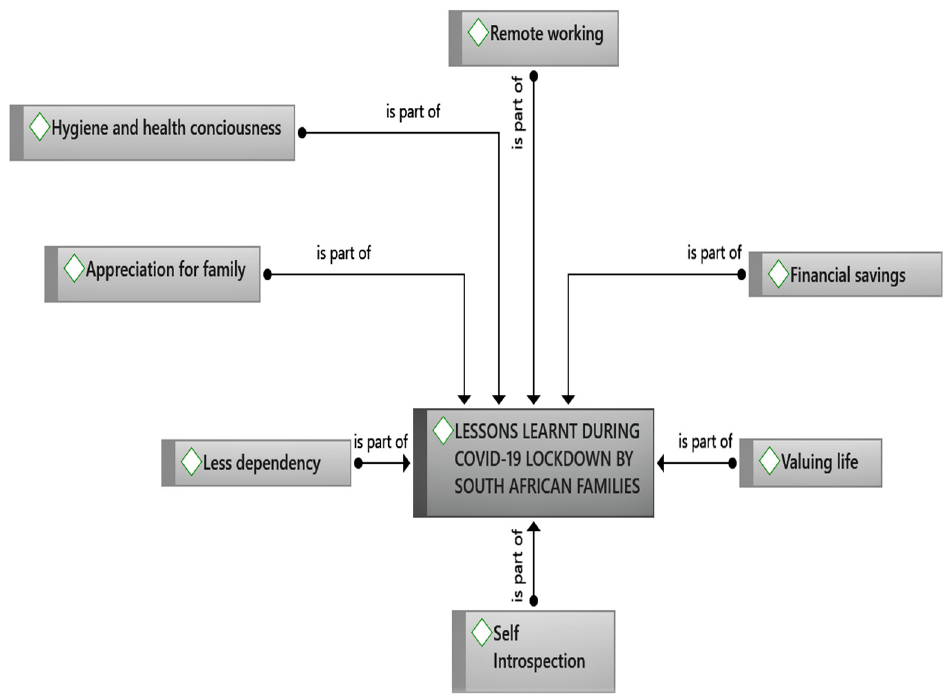
Figure 2. Summary of the study sub ‐ themes.